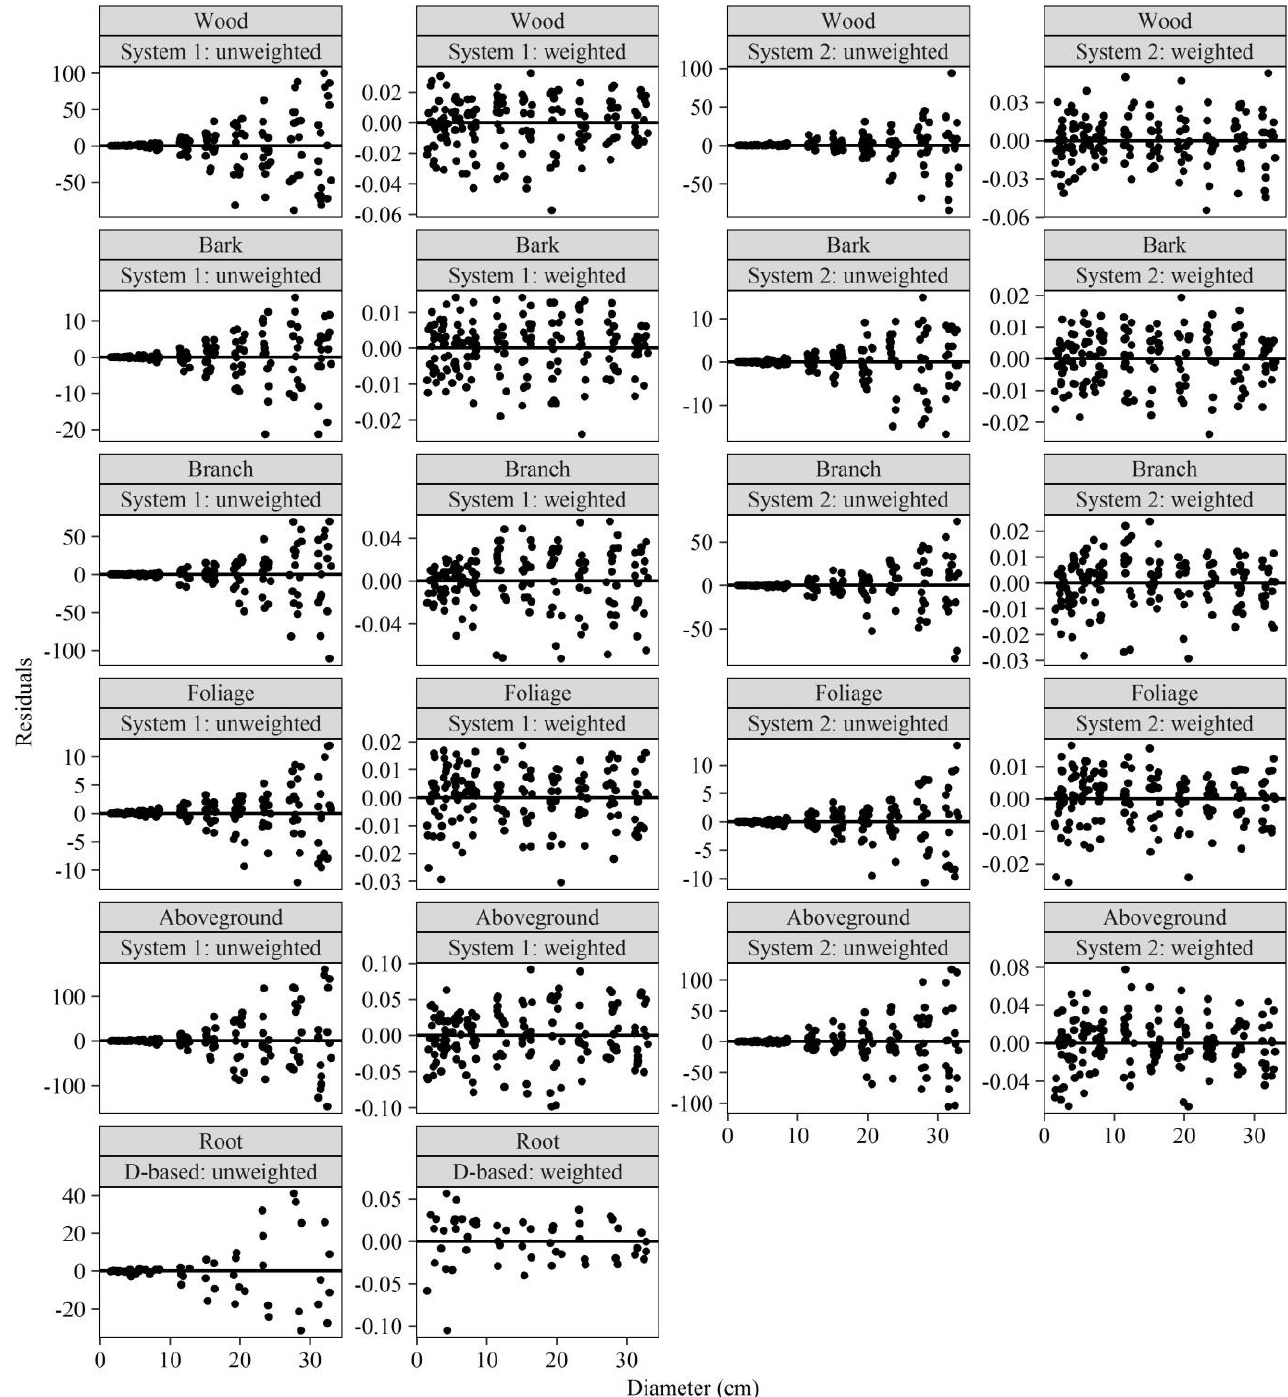
Figure 8. The heteroscedastic and homoscedastic residual errors of the original biomass models (unweighted) and the biomass models with weighting functions (weighted).